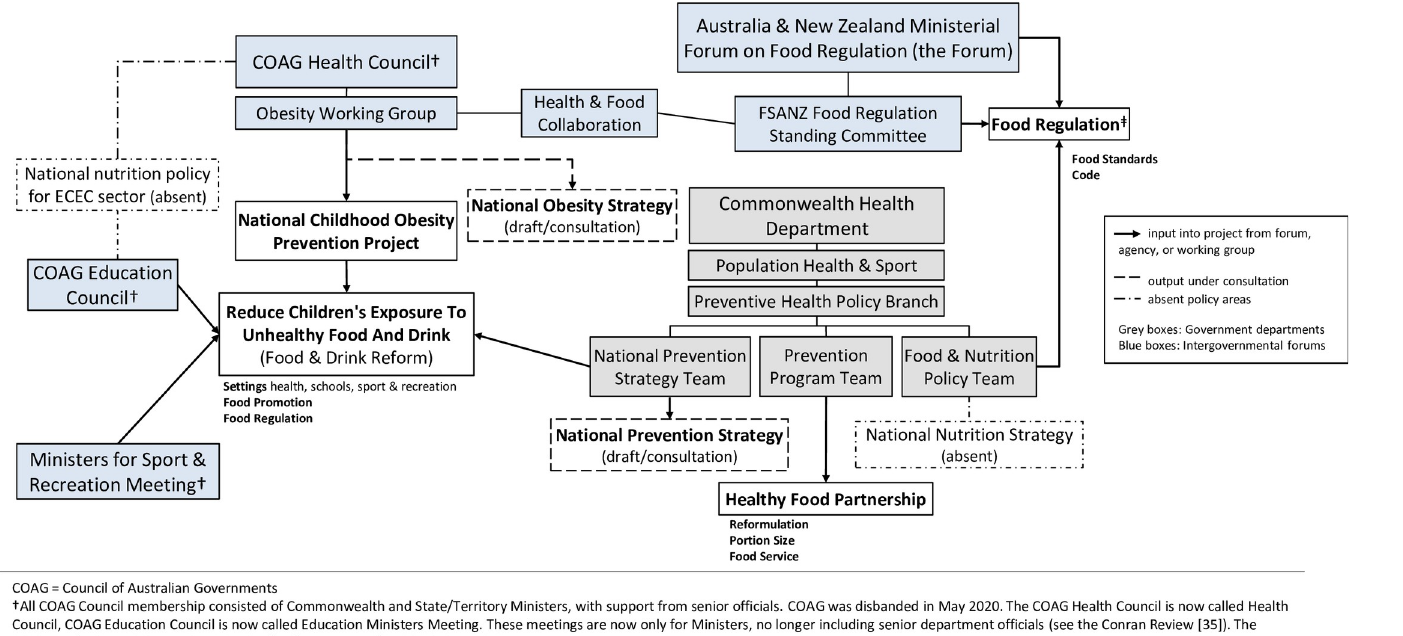
Fig 1. National obesity prevention